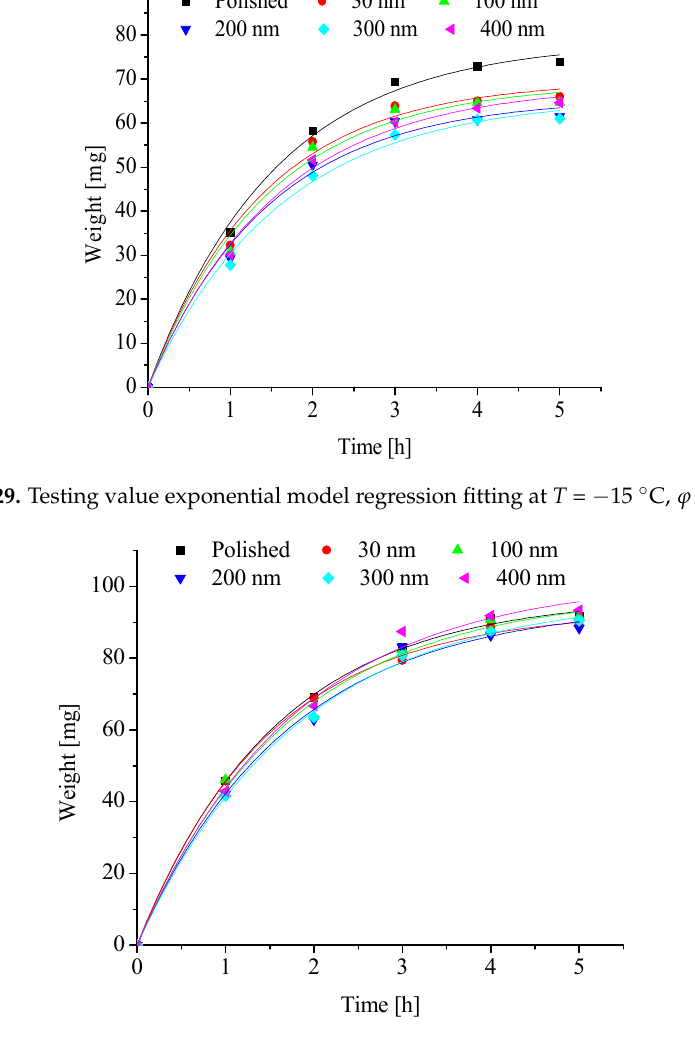
Figure 30. Testing value exponential model regression fitting at T = − 20 °C, φ = 90%.